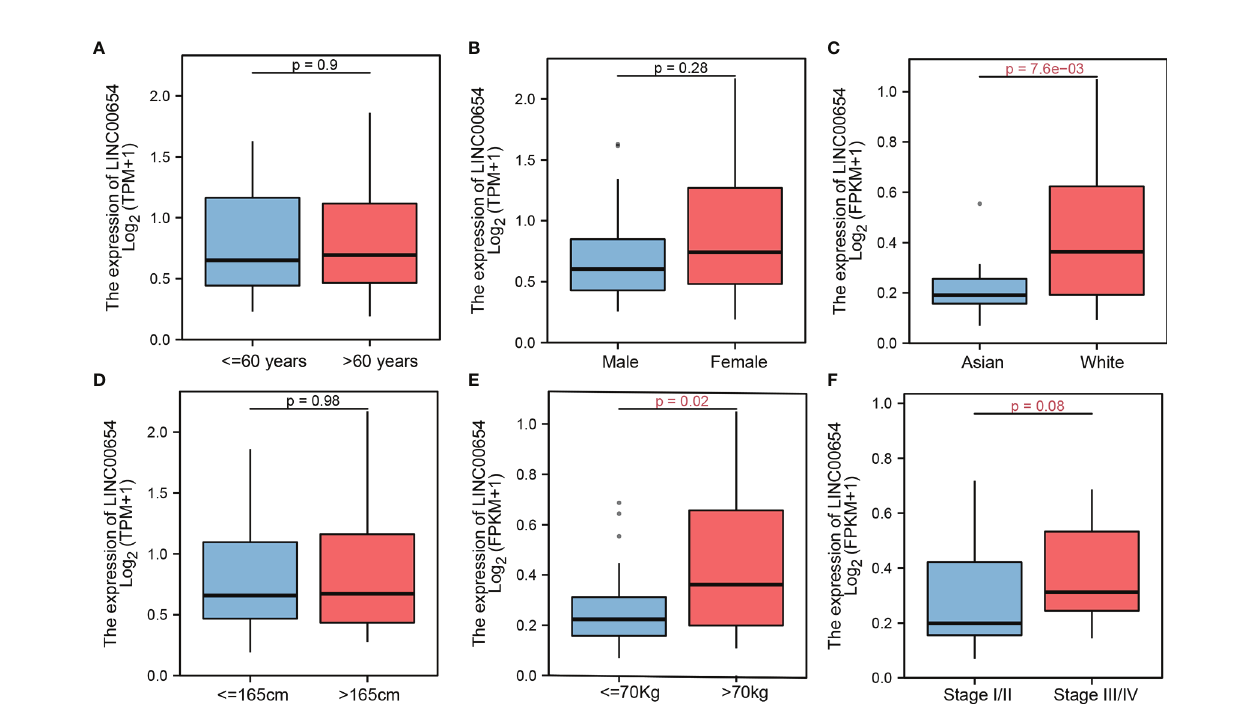
FIGURE 2 | LINC00654 distribution by clinical factors. lnc00654 distribution in different clinical characteristics, in age and sex groups, no signi fi cance between groups, respectively (p=0.9 vs. p=0.28) (A, B) , lnc00654 expression signi fi cance between race groups (p=7.6e-03) (C) while no signi fi cance between the higher groups (p=0.98) (D) , during in weight and groups, lnc00654 expression high in patients with weight more than 70kg and with tumor in advanced stage (p=0.02 vs. p=0.08) (E, F)